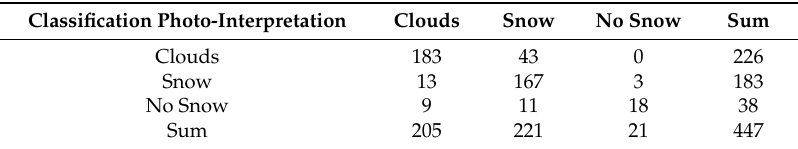
Table 4. Confusion matrix of PROBA-V for comparison with MOD10.